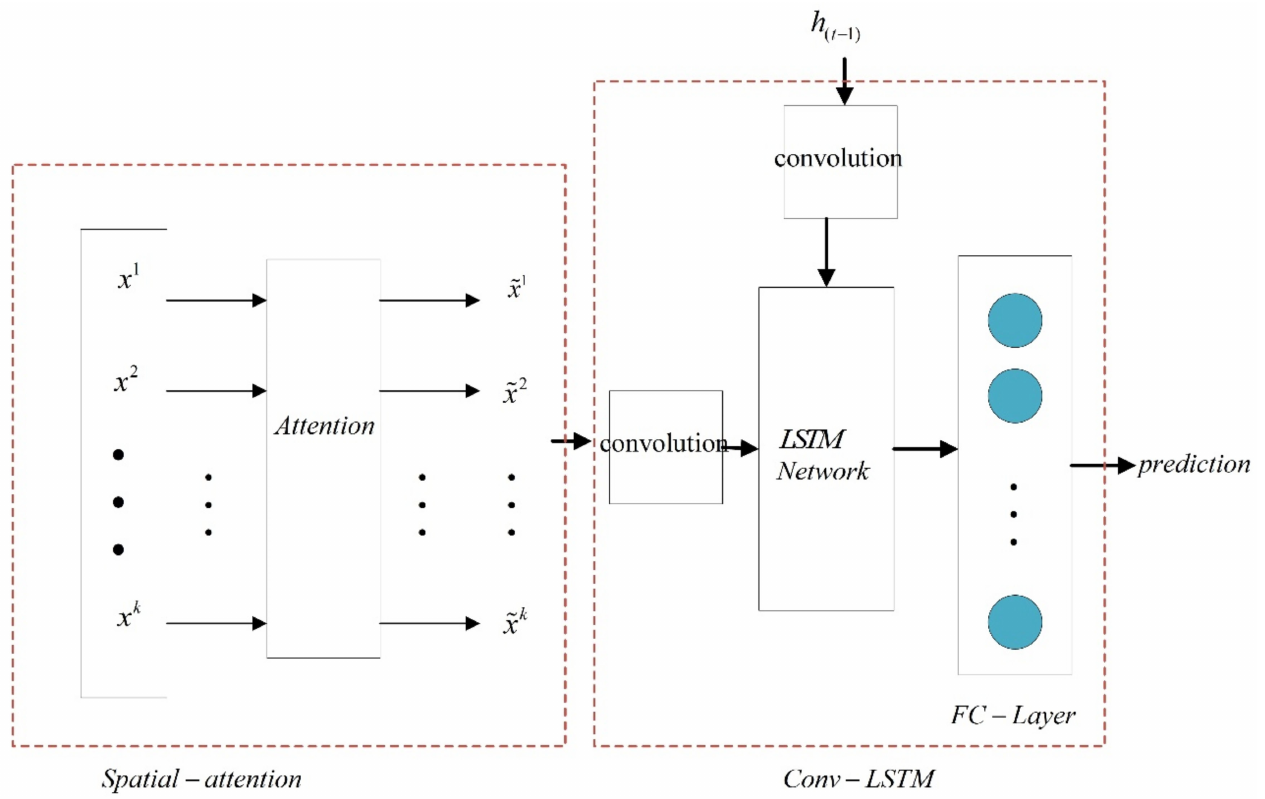
Figure 3. Framework of the proposed